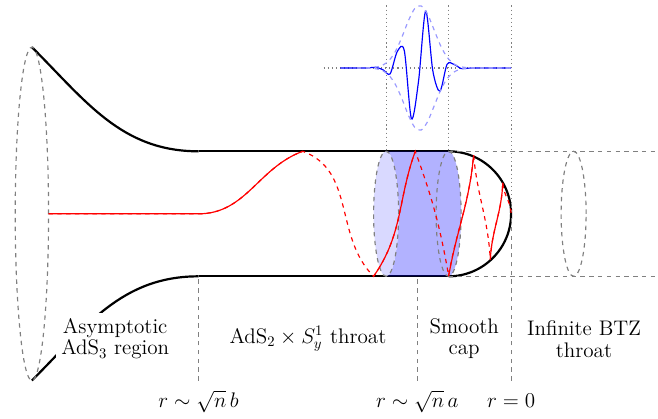
Figure 1 . A schematic depiction of the (1 , 0 , n ) superstrata in the r − y directions. The red curve depicts a trajectory of an infalling and spiralling null geodesic along which a string probe is travelling. The details of the microstructure are most prominent at the bottom of the throat (shaded in blue), where the tidal forces are greatest. The curve in blue above the geometry illustrates the alternation between tidal stretching and compressing the string experiences as it approaches the cap